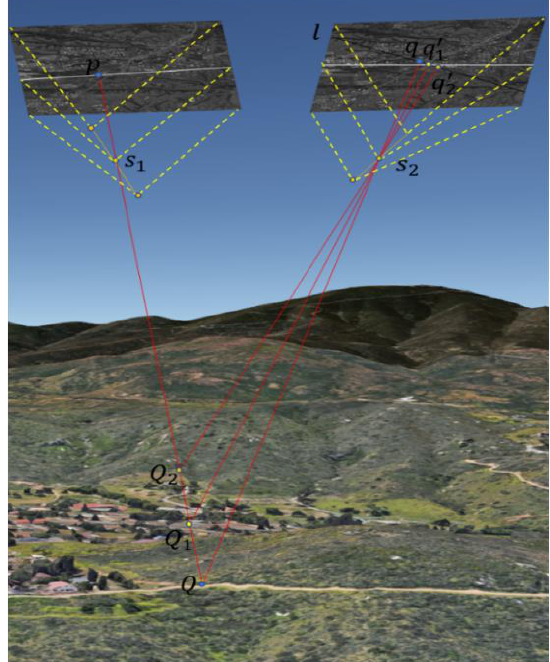
Figure 1. The projection trajectory-based epipolarity model. The white line on the left and right images indicate the scan line when imaging, while the black line on the right image indicates the epipolar curve 𝑙 of the point 𝑝 on the left image.